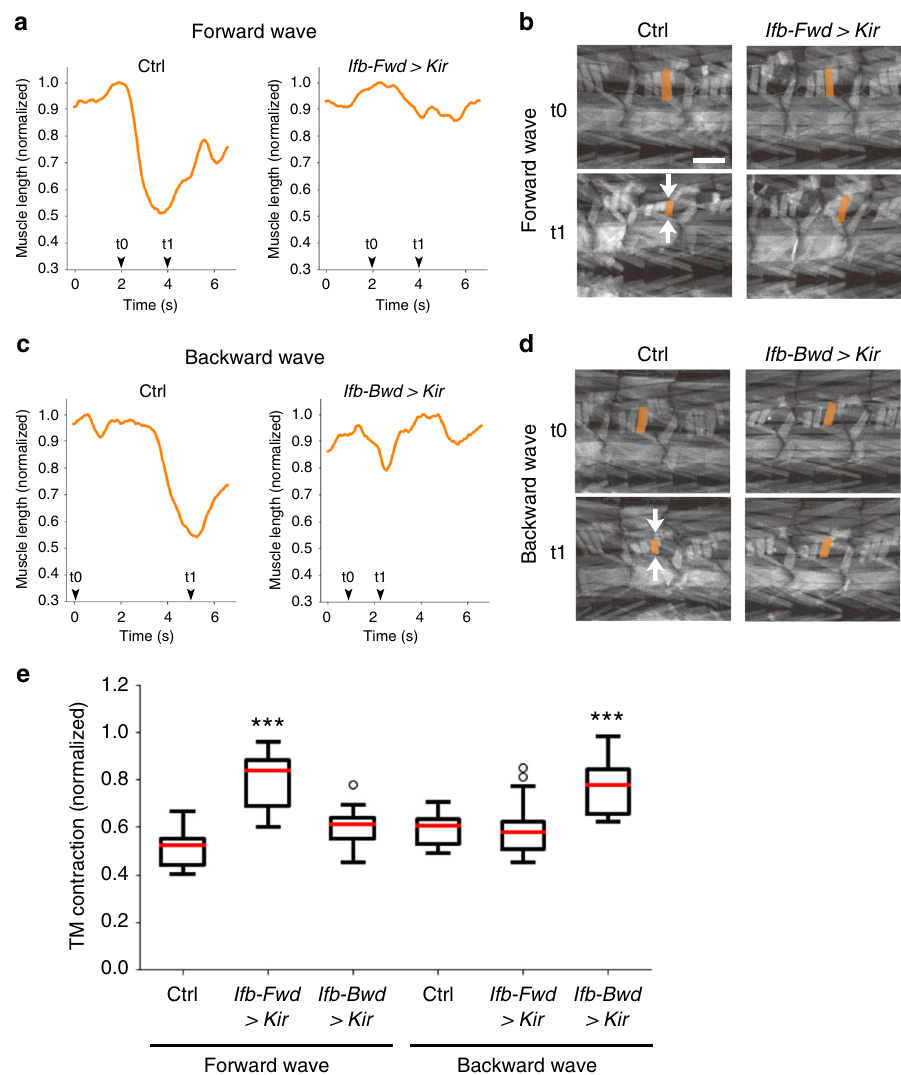
Fig. 7 Ifb-Fwd and Ifb-Bwd are required for the contraction of transverse muscles. a – d Muscle imaging using mhc-GFP during forward ( a , b ) and backward propagation ( c , d ). a , c The lengths of transverse muscles M23 are plotted. b , d Images of body wall muscles during wave propagations. White arrows indicate the contraction of the transverse muscle. Note the reduction in the contraction of transverse muscles during forward waves when the activity of Ifb-Fwd is blocked ( a , b ) and the reduction in the muscle contraction during backward waves when the activity of Ifb-Bwd is blocked ( c , d ). e Quanti fi cation of the contraction of transverse muscles. Data size: 10 – 18 waves from 4 to 6 larvae for each group. *** p < 0.005 (Ifb-Fwd > Kir: p = 5.6 × 10 − 9 ; Ifb-Fwd > Kir: p = 0.0031 by the two-sided Student ’ s t -test with the Bonferroni correction). See Methods section for statistical analysis. Center line, median; box limits, upper and lower quartiles; whiskers, 1.5× interquartile range; points, outliers. Scale bar, 200 µ m ( b , d ) Calcium imaging . Third-instar larvae were dissected by microscissors 22 . The CNS diameter) was held at 32 °C on a heat plate (ThermoPlate, Tokai Hit, Japan). Third- was isolated by cutting off the nerves, tracheae and imaginal discs, and then placed instar wandering larvae were gently washed in deionized water and lifted on the in a drop of saline on a MAS-coated slide glass (Matsunami glass, Japan). The agar plate for acclimation (60 sec). The larvae were then videotaped under ste- saline was replaced with TES buffer (TES 5mM, NaCl 135 mM, KCl 5 mM, MgCl 2 reoscopic microscopy (SZX16, Olympus, Japan). The speed of the propagation was measured manually using ImageJ software (NIH). 4mM, CaCl 2 2mM, sucrose 36mM; pH = 7.15). The fl uorescence of GCaMP6f was detected by a spin-disk confocal unit (CSU21, Yokogawa, Japan) and an EMCCD camera (iXon, Andor Technology, Germany) attached to an upright microscope, Axioskop2 FS (Zeiss, Germany) with a 60x water immersion objective lens. Dual-color calcium imaging of GCaMP6f and R-GECO1 was carried out by using a dual view system (CSU-DV, Solution Systems, Japan) 22 . For detecting peaks of the calcium imaging data in Fig. 6 and Supplementary Fig. 7, the original raw data were smoothed by the Savitzuky-Golay fi lter. Data analyses were con- ducted by ImageJ (NIH, USA) and Python3 scripts. For evaluating correlated activity between Ifb neurons and A02e for each wave (Fig. 3), we calculated the correlation coef fi cient between A02e activity (which was fi t to the Gaussian function) and a raw trace of Ifb neuron activity by Python3. Larval locomotion assay . To conditionally inhibit neural activity using temperature-sensitive dynamin mutant Shibire ts48 , an agar plate (about 9cm in NATURE COMMUNICATIONS| (2019) 10:2654